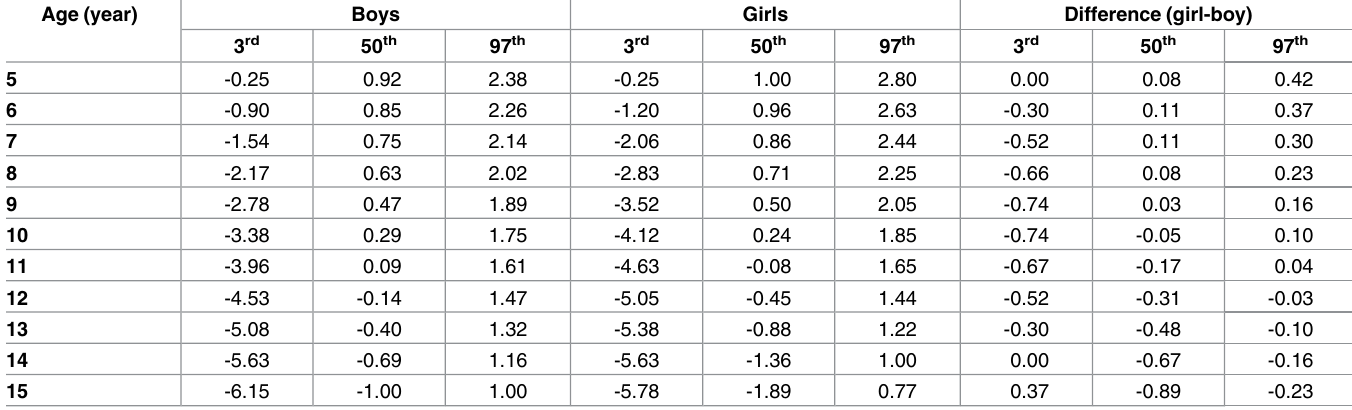
Table 1. Refraction (diopter) cutoff of boys compared with that of girls at different age and centile using population-based data of the Guangzhou RefractiveError Study in Children (RESC)